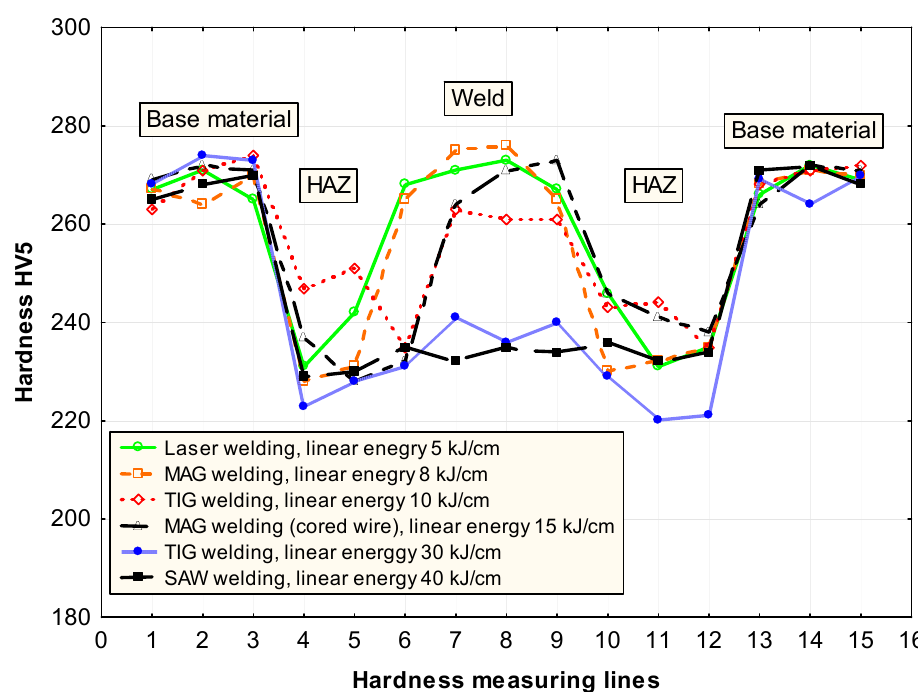
Figure 8. Effect of welding method and input heat on the hardness on the cross section of the S700MC welded joints.